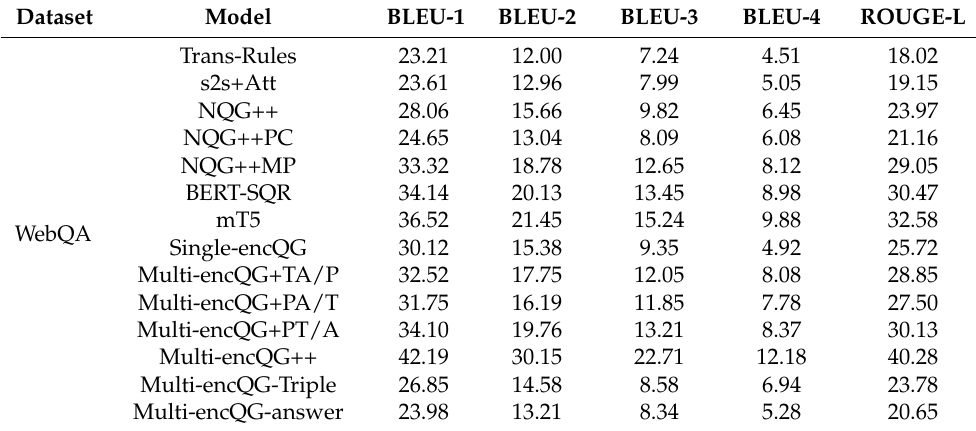
Table 4. Machine evaluation results of different question generation models on the Baidu Q and A dataset. Top 3 ranked triples were incorporated into Multi-encQG models. Dataset Model